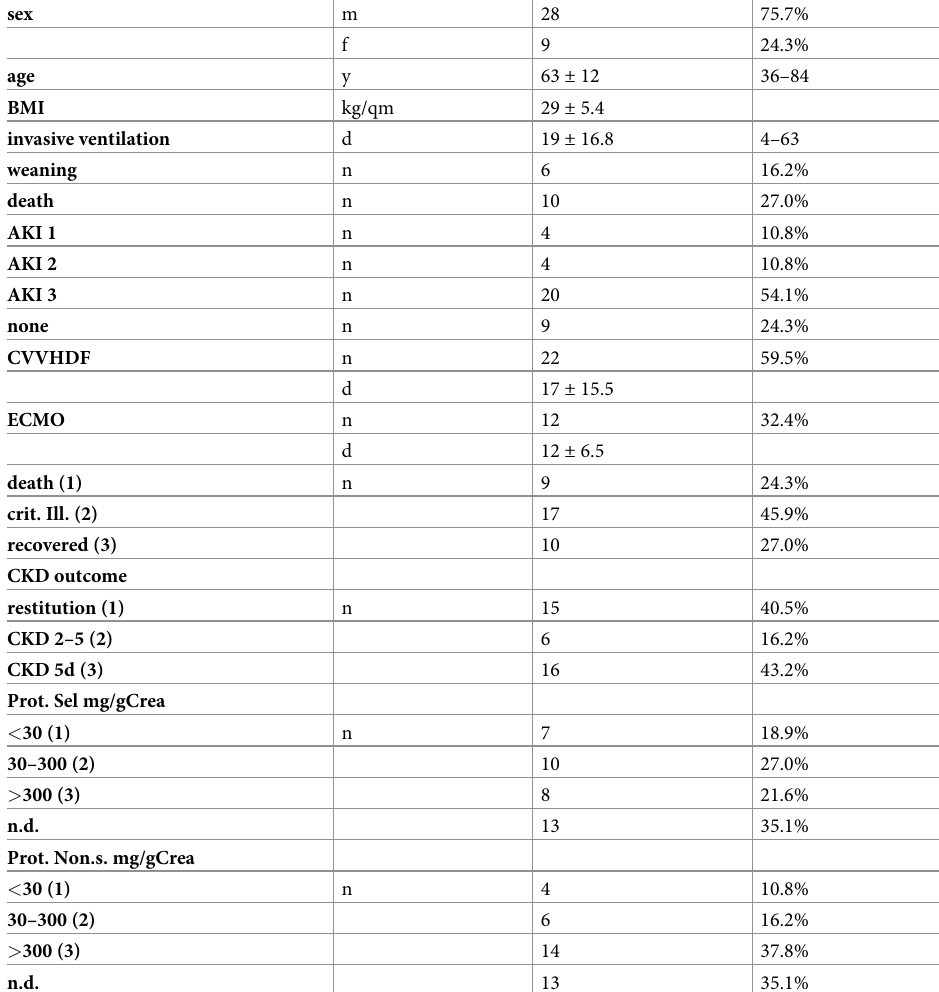
Table 1. Patients